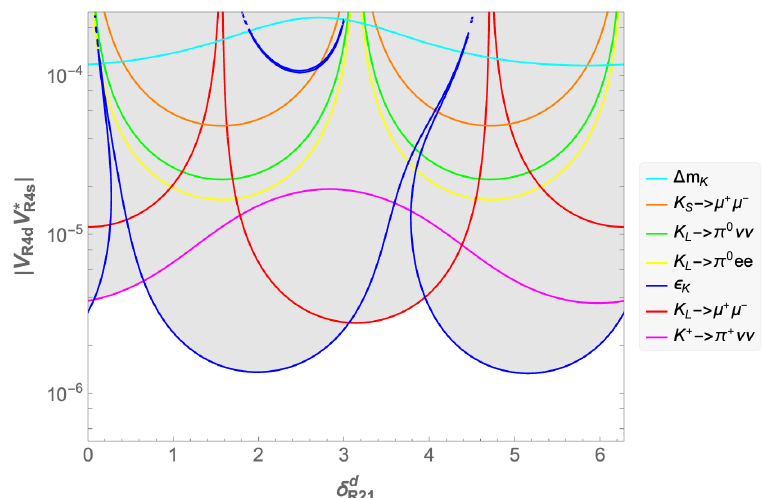
Figure 18 . Upper limits on the product | V ∗ kaon mixing, as a function of the relative phase δ d